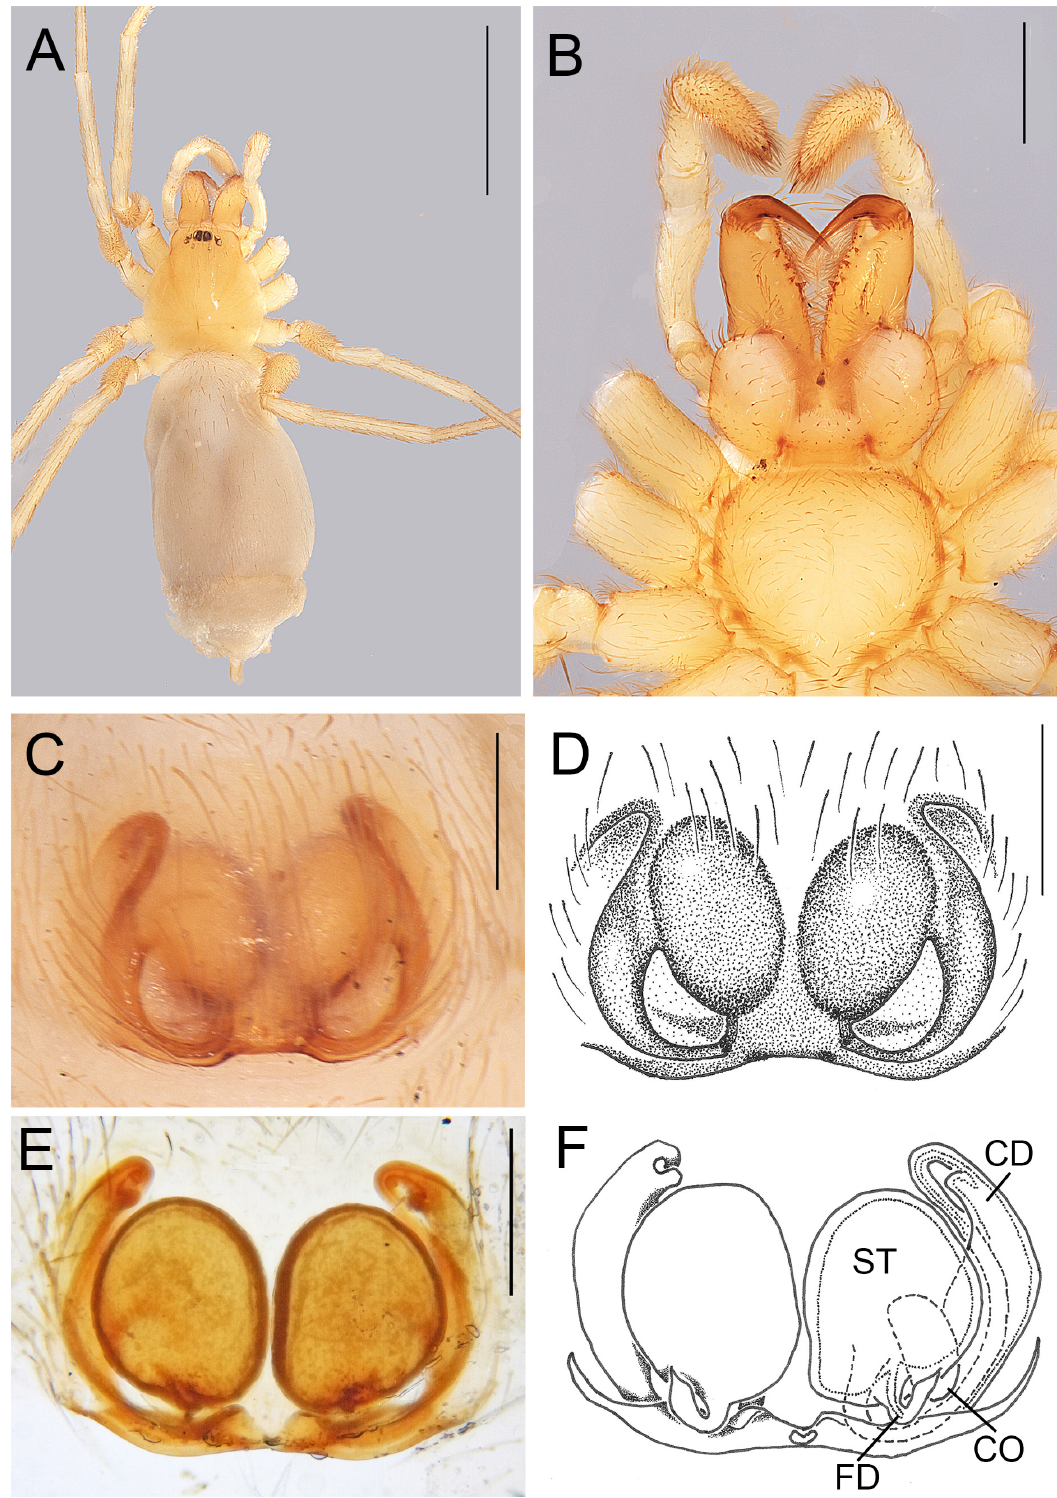
Fig. 24. Andromma ghesquierei sp. nov., ♂, holotype (BE_RMCA_ARA.Ara 247536). A . Habitus, dorsal view. B . Same, ventral view. C–D . ♂, left palp, ventral view. E–F . Same, retrolateral view. Abbreviations: CD = copulatory duct; CO = copulatory opening; FD = fertilisation duct; ST = spermatheca. Scale bars: A–B = 1 mm; C–F = 0.2